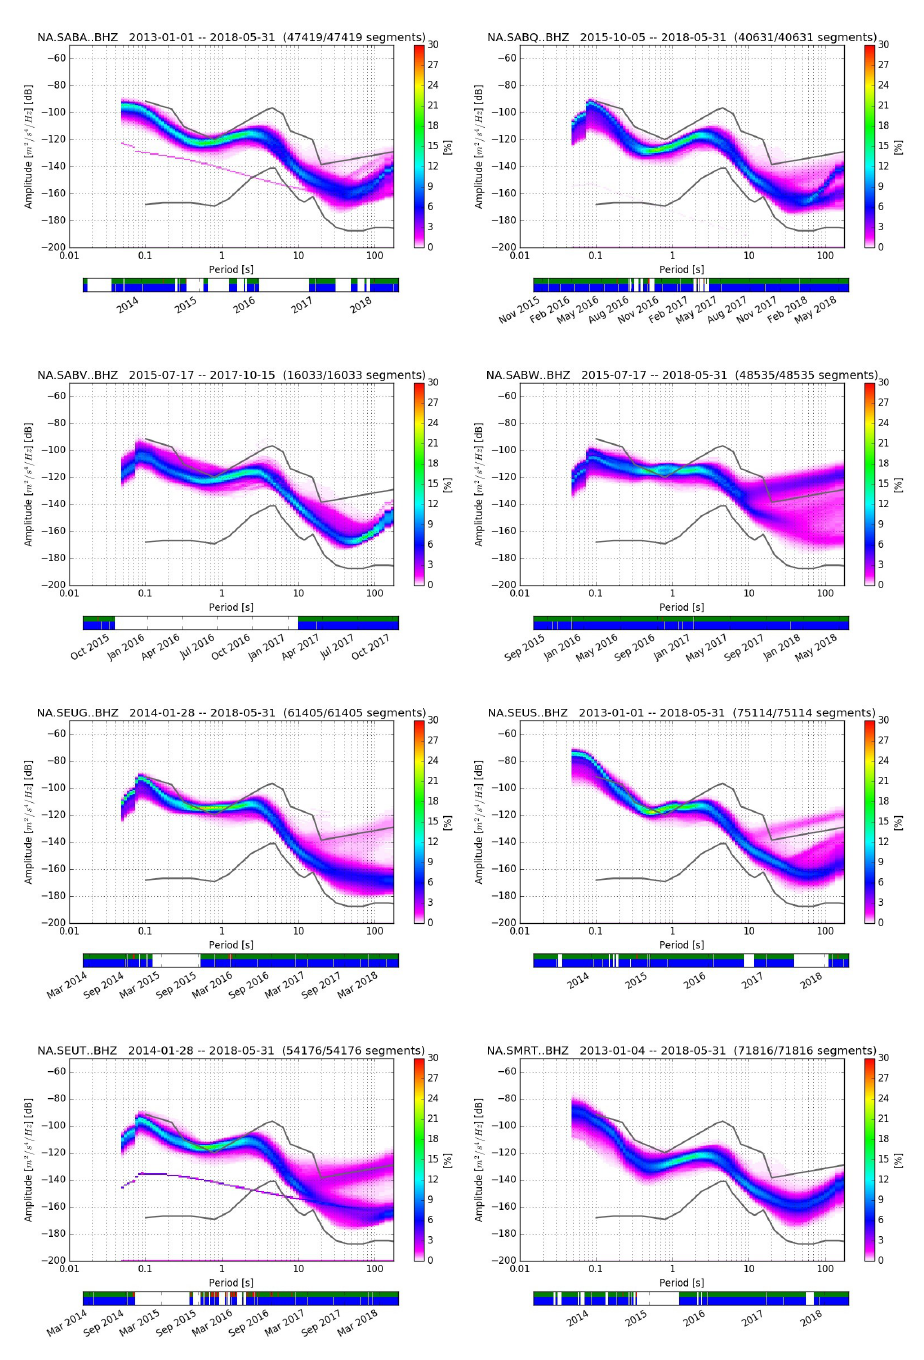
Figure 6. Seismic noise Probability Density Function (PDF) from the vertical component 40 sps recordings of the NA seismic stations in dB relative to ground acceleration between 1 January 2013 and 1 June 2018. The black lines are Peterson’s high and low noise models [24]. The red lines in the figures for SABA and SEUT are related to recordings that are affected by out-of-balance boom positions. The horizontal bar below the PDF plots shows the data used from each station between 1 January 2013, or the starting date of the station hereafter, and 1 June 2018. Note: because of the different starting dates of the seismic stations, the horizontal bars differ in time span. The green color in the top row represents the available data, and the red color represents data with gaps that were used in the PSD calculations. The bottom row, in blue, shows data that were used in the PDF plot. Data gaps show up as empty segments, where segments have a length of 30 min